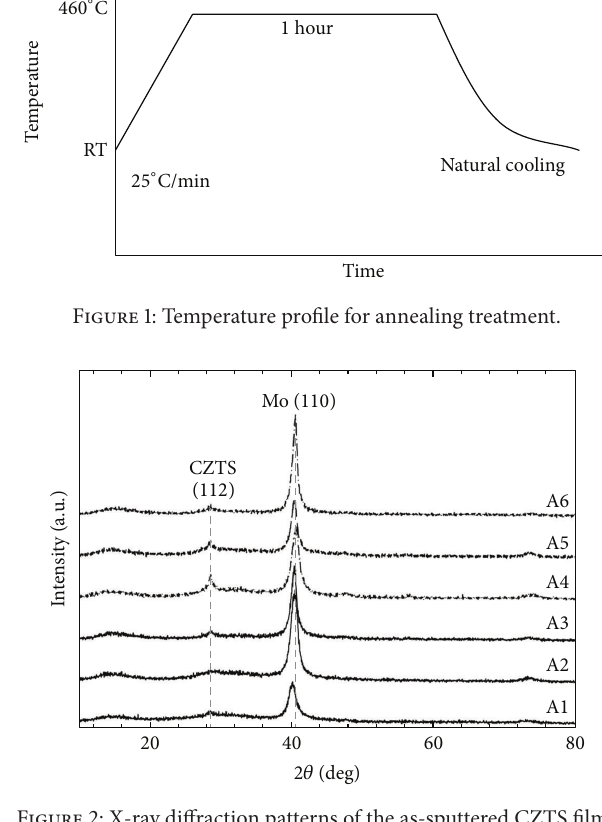
Figure 2: X-ray diffraction patterns of the as-sputtered CZTS films grown at various substrate